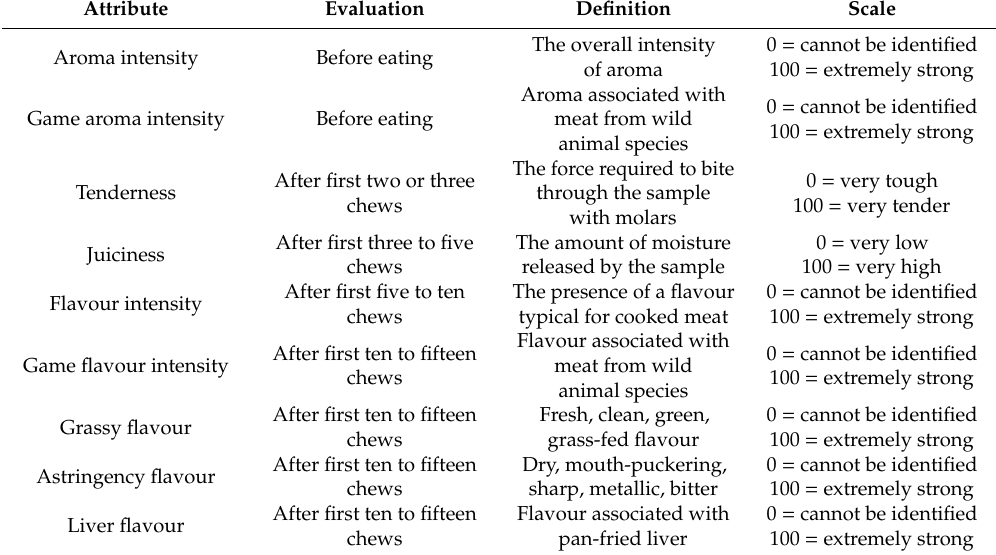
Table 2. Definition and scale of attributes used in sensory analysis of farmed fallow deer